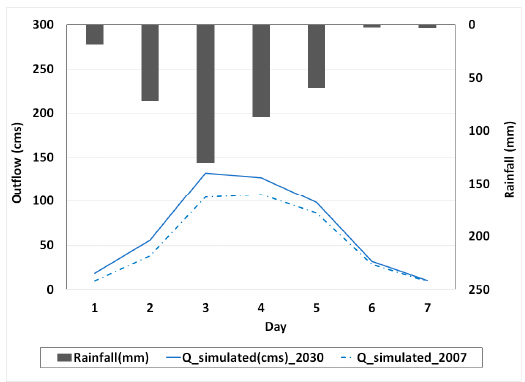
Figure 4. The influence of land ‐ use changes on outflow at the Katulampa station with the same rainfall intensity during 2007 and 2030.